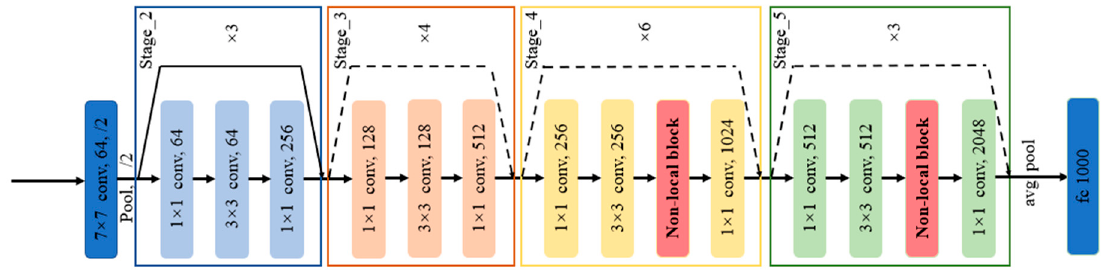
Figure 4. Improved ResNet based on non-local block. The transformer architecture in Deformable DETR remains unchanged. The overall structure of Non-local Deformable DETR is shown in Figure 5.